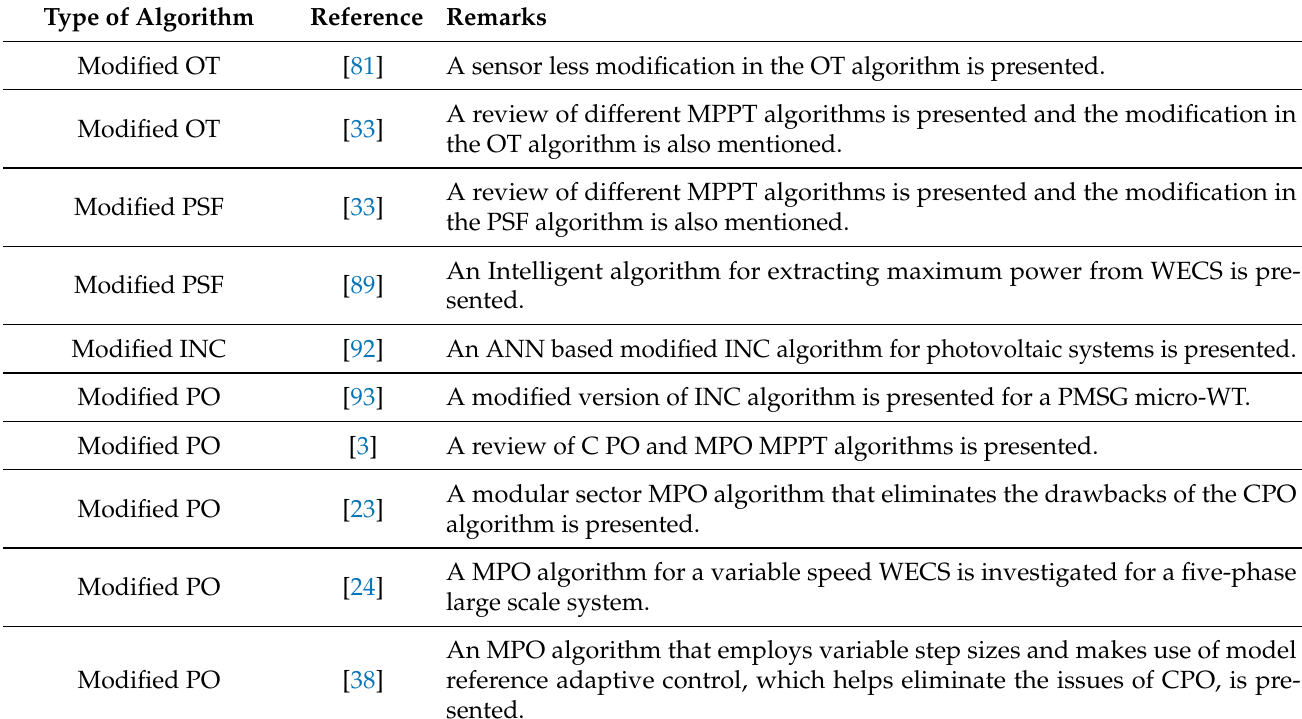
Table 6. Summary of references for the modified MPPT